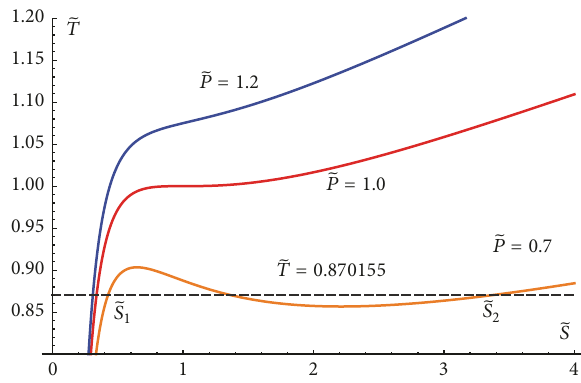
̃𝑇 = 0.870155 equally separates the